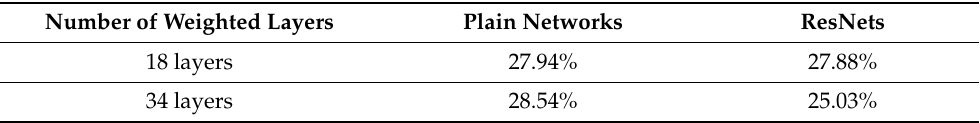
Table 1. Top-1 error (%, 10-crop testing) of plain networks and ResNets in ImageNet validation (source: